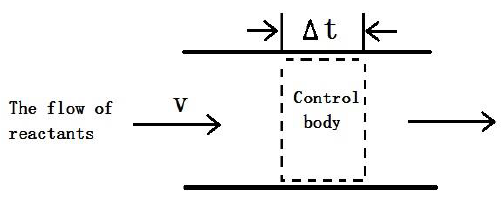
Figure 2. The plug–flow model. Figure 2. The plug – flow model. Figure 2. The plug – flow model.